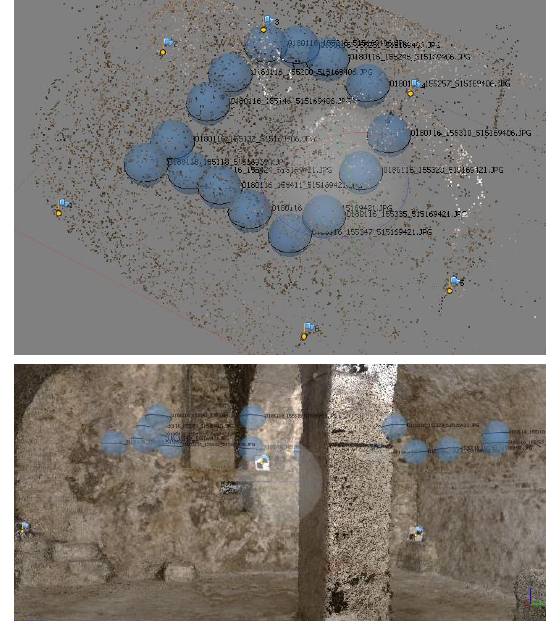
Figure 5. Orientation of images acquired in a cellar. Dense image matching provided a point cloud that was compared to a reference dataset measured with a Faro Focus 3D laser scanner.